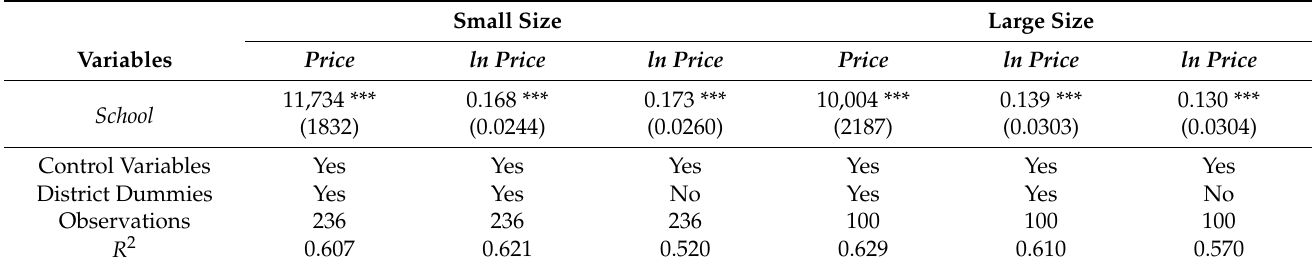
Table 5. Heterogeneous effects for small and large houses (hedonic price model).